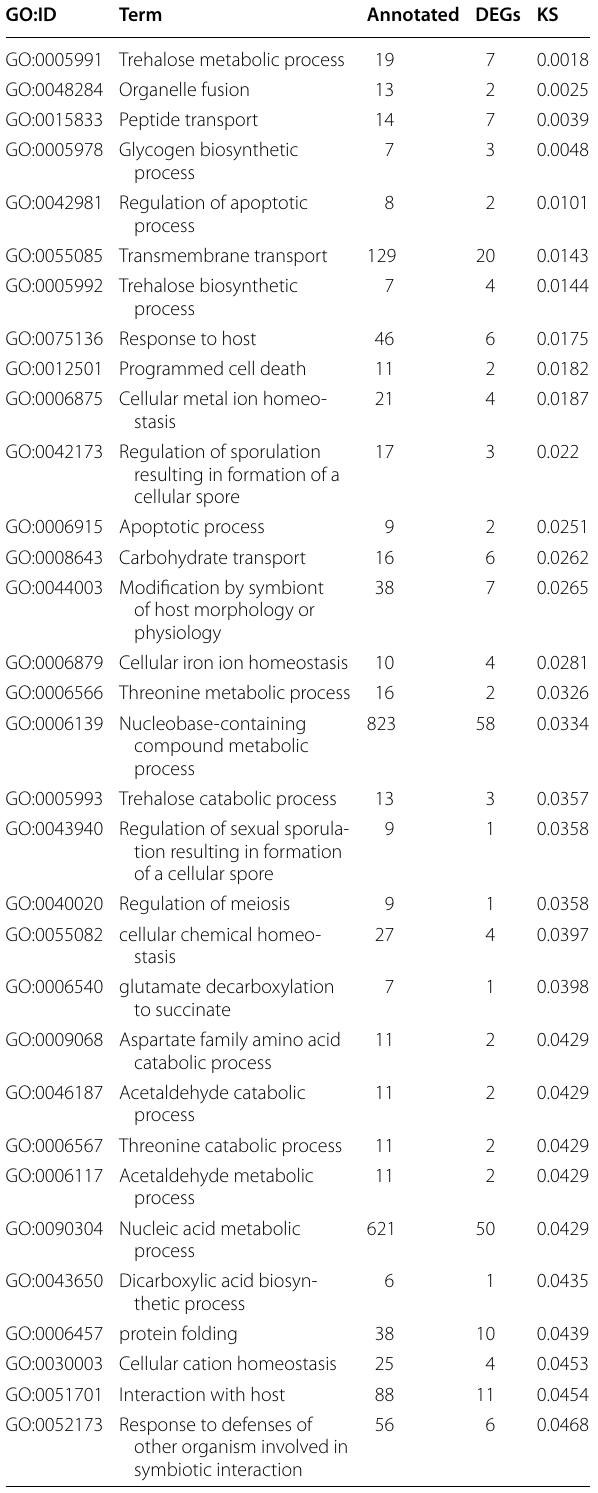
Table 1 Enriched biological process terms of the DEGs after ethanol stress (KS <